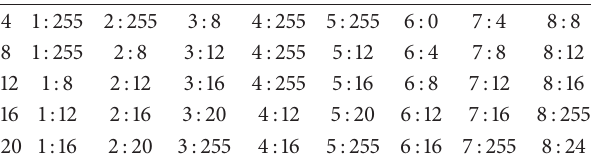
Table 1: Example of regression training vectors (LIBSVM format) taken from images in Figure